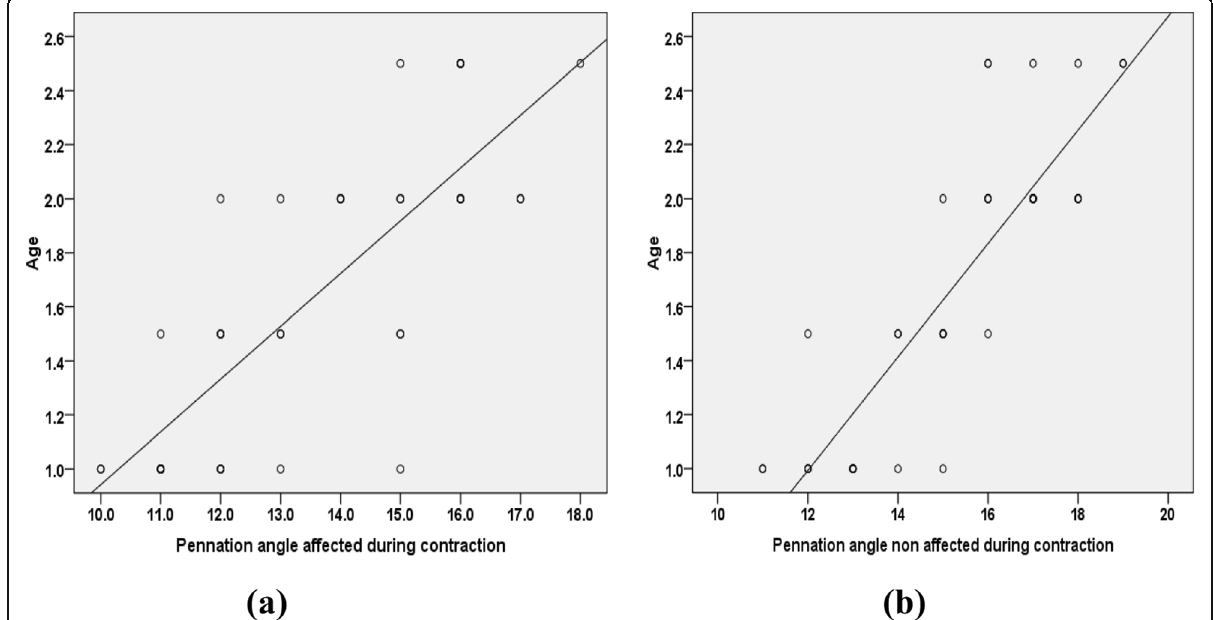
Fig. 5 a Correlation between age and pennation angle in the affected side during contraction ( r = 0.797; P = 0.001). b Correlation between age and pennation angle in the nonaffected side during contraction ( r = 0.864; P = 0.001)